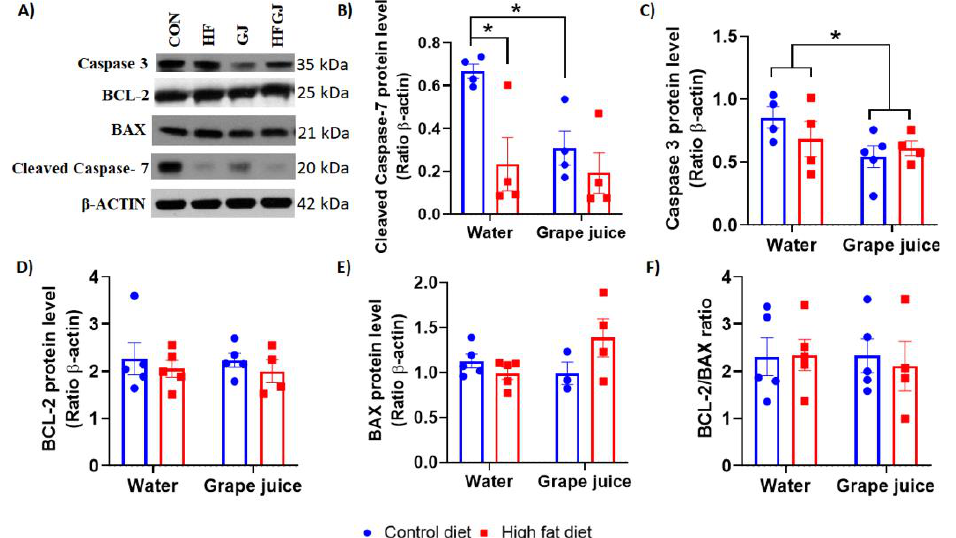
Figure 2. (A) Representative Western blots and quantitated data of (B) cleaved caspase-7, (C) cleaved caspase-3, (D) BCL-2, (E) BAX and (F) the BCL-2/BAX (E) protein ratio in mammary glands of